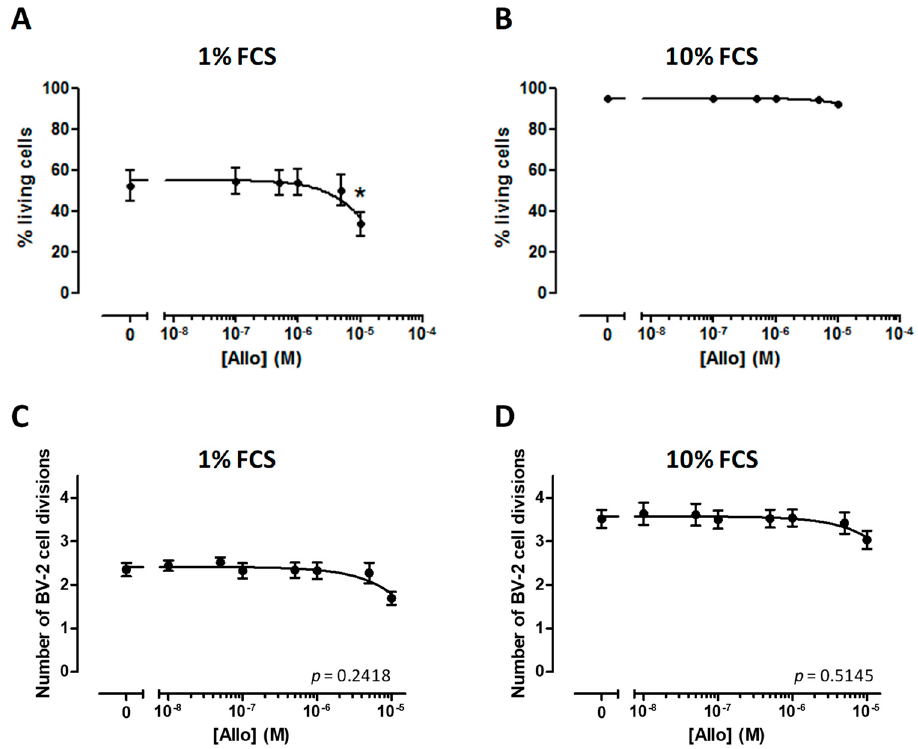
Figure 3. Effect of allopregnanolone (ALLO) on the viability and proliferation of BV-2 cells. ( A , B ) The viability of BV-2 cells was investigated by flow cytometry following incubation with graded concentrations of ALLO. ( C , D ) The dilution of CFSE showed that proliferation of BV-2 cells grown with 1% or 10% FCS is not modified in presence of ALLO. Mean values ± SEM are shown, from n = 4 independent experiments, * p < 0.05.